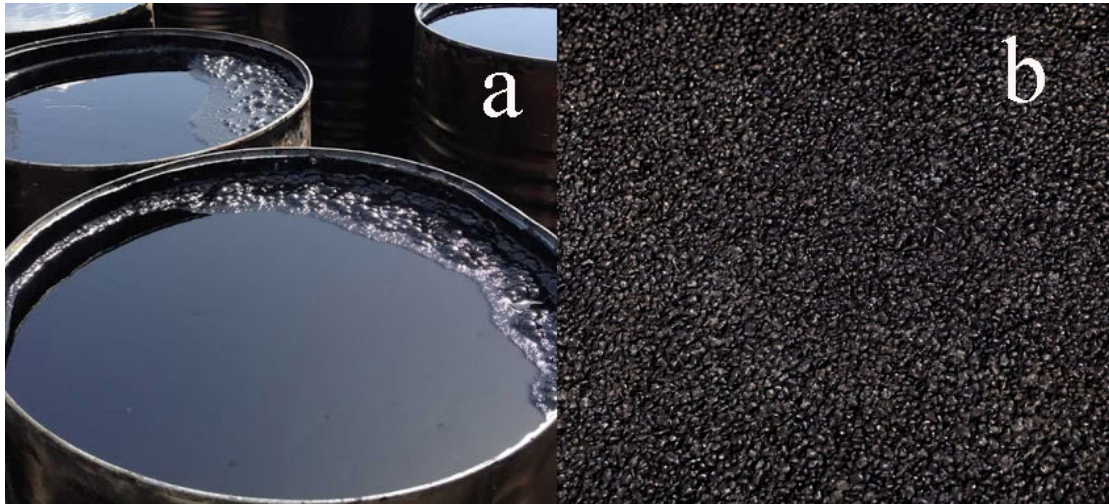
Figure 3: (a) Bitumen; (b)